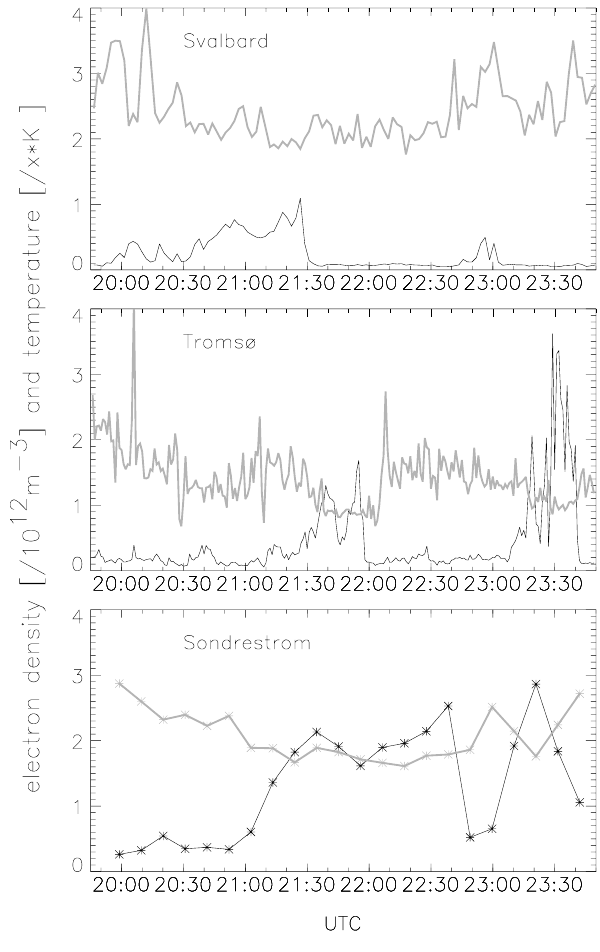
Fig. 5. EISCAT time series of the ESR42 Svalbard and the UHF Mainland radar at Tromsø at 410km altitude, as well as of the Son- drestrom radar at 428km for 30 October 2003: electron density (black line) and temperature (grey line) scaled by x = 1000 for Sval- bard and Sondrestrom, and by x = 2000 for Tromsø. Asterisks on the lowest panel give the sampling time of